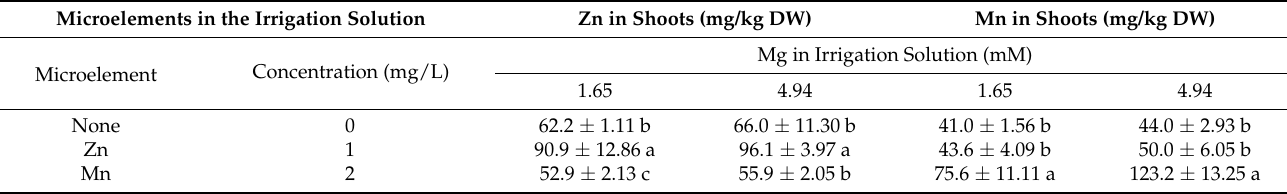
Values for each Mg treatment and each microelement treatment that are followed by a different letter are significantly different according to one-way ANOVA with Tukey’s HSD